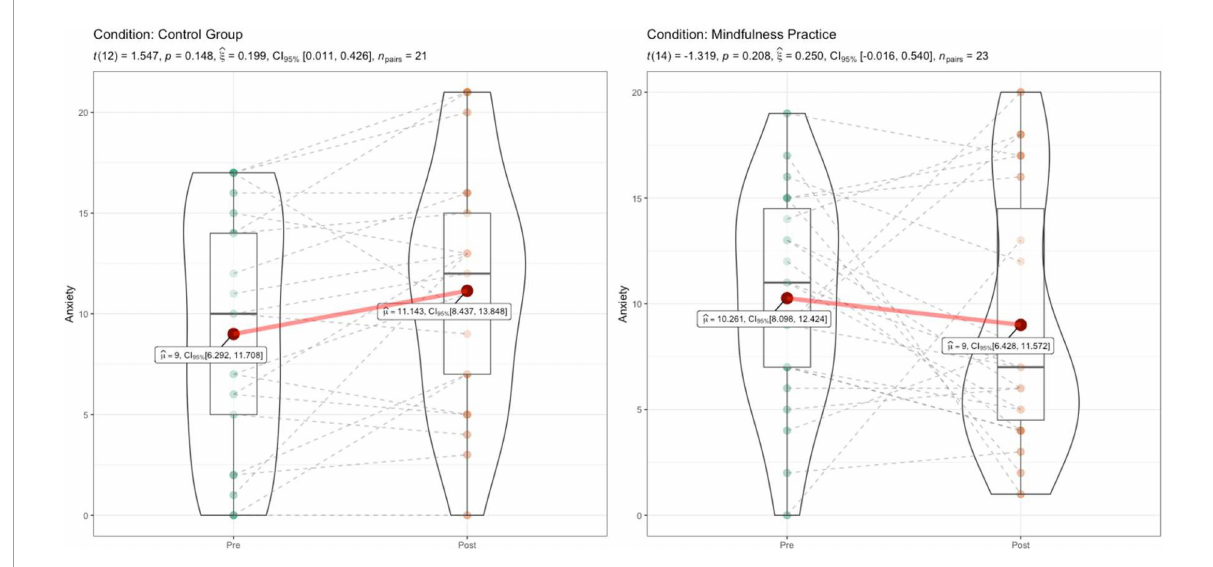
FIGURE4 Evolution of experimental and control conditions between T1 and T2 for the anxiety